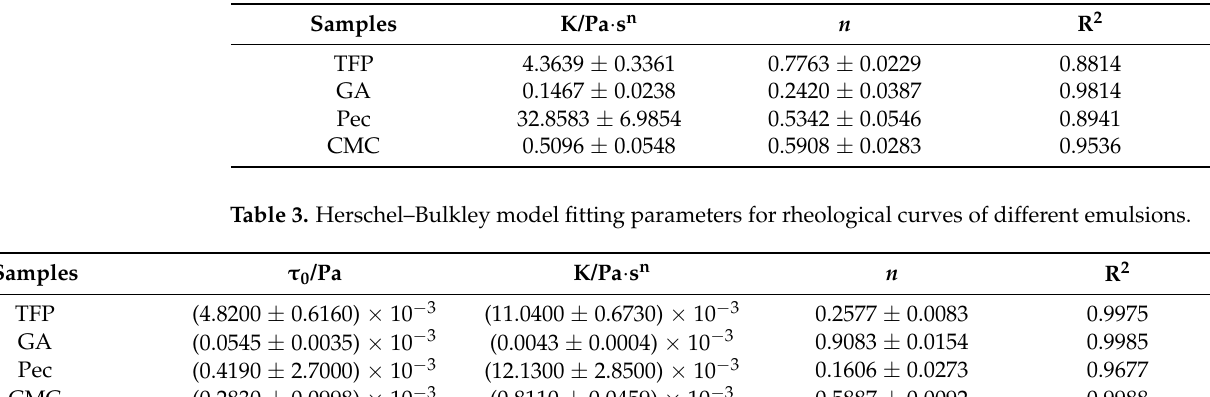
Table 2. Power-Law model fitting parameters for rheological curves of different emulsions.